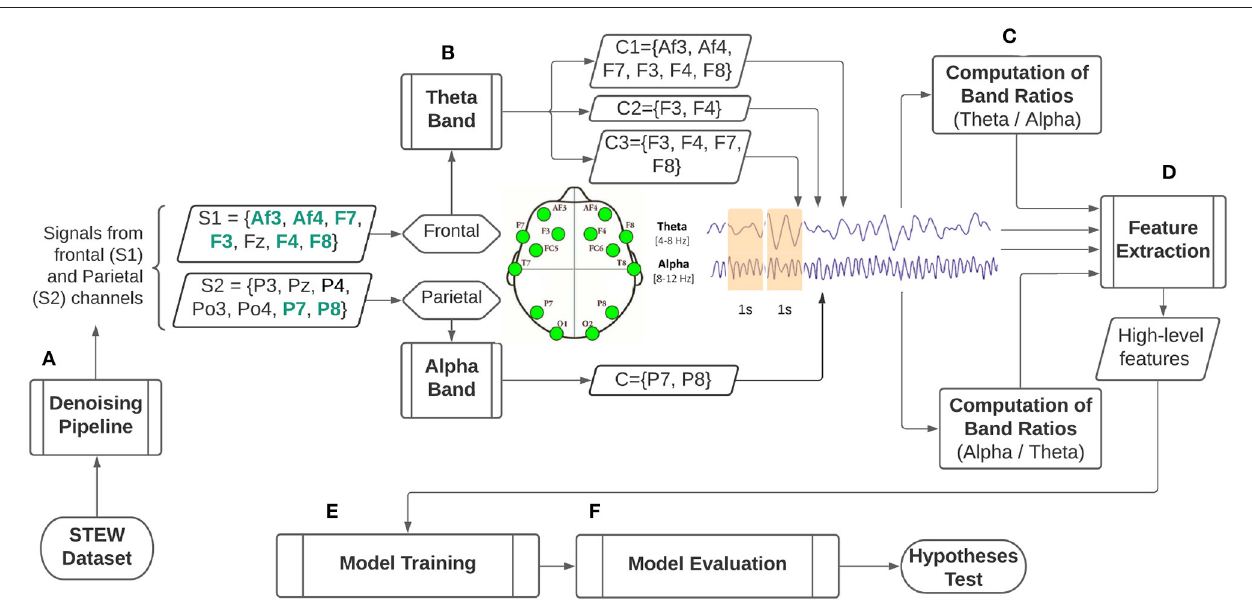
FIGURE 1 | Illustrative process for classification of self-reported perception of mental workload based on mental workload indexes built upon the EEG alpha and theta bands. (A) Signal denoising pipeline. (B) Electrode selection for theta band from frontal cortical areas and alpha band from parietal cortical areas and their aggregation to form electrode clusters. (C) Computation of the mental workload indexes employing the EEG alpha-to-theta and theta-to-alpha band ratios. (D) Extraction of high level features from mental workload indexes. (E) Model training for self-reported perception of mental workload classification employing machine learning. (F) . Model evaluation for hypothesis